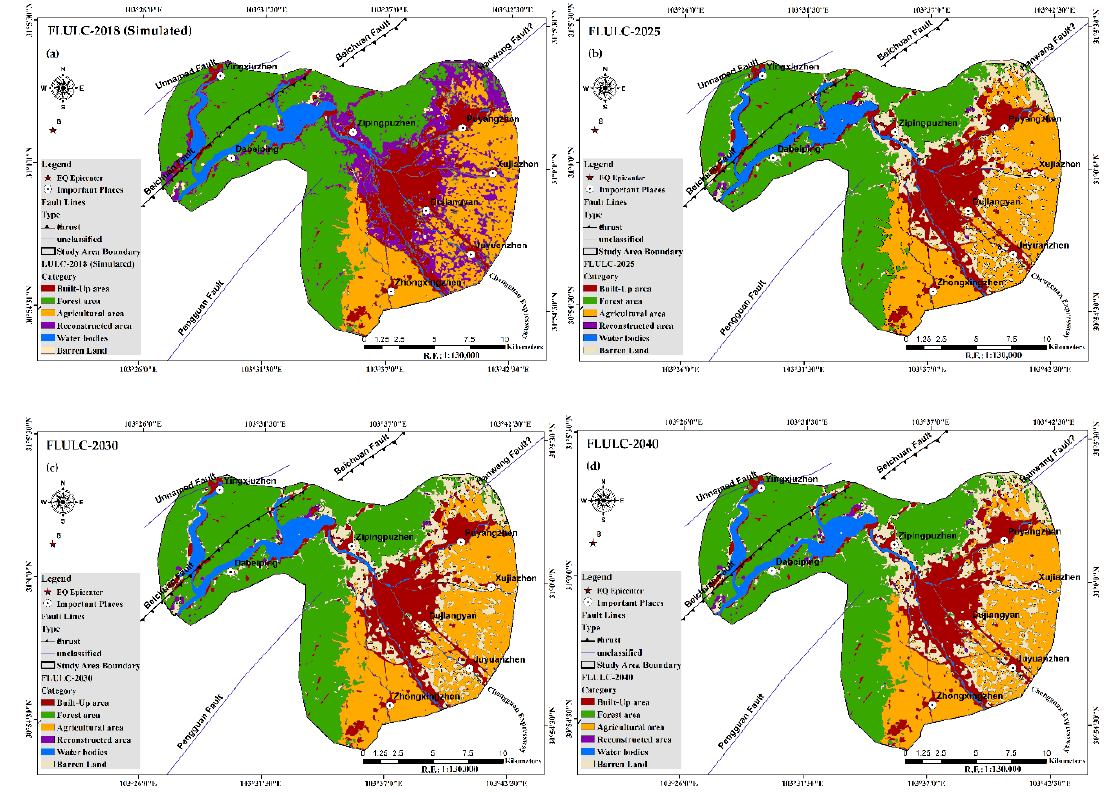
Figure 5. FLULC distribution of the study area in four different time periods (simulated 2018-2040); (a) LULC simulated-2018, (b) FLULC-2025, (c) FLULC-2030, (d) FLULC-2040. Table 6. Dynamic degree (DD) (%) estimation between different times based on LULC total area coverage (km 2 ) from 2018 to 2040.